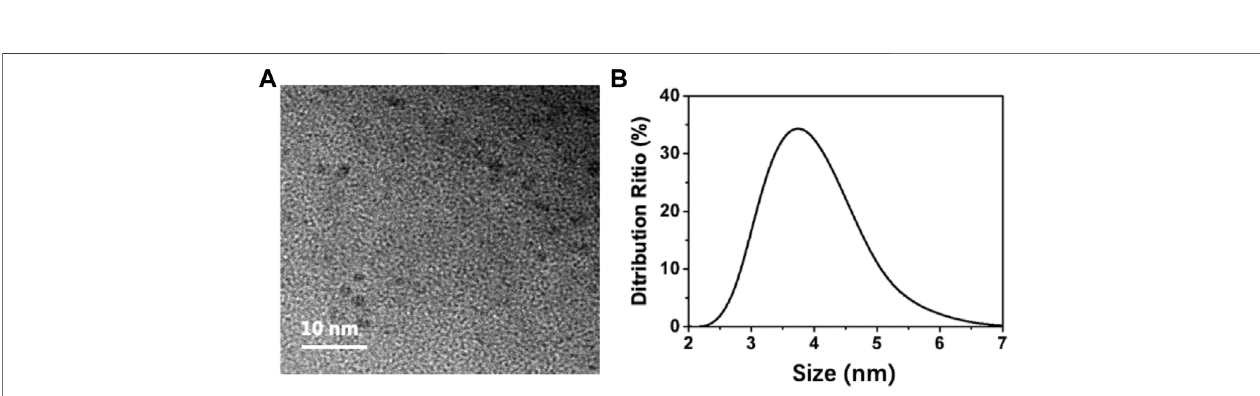
Frontiers in Bioengineering and Biotechnology |